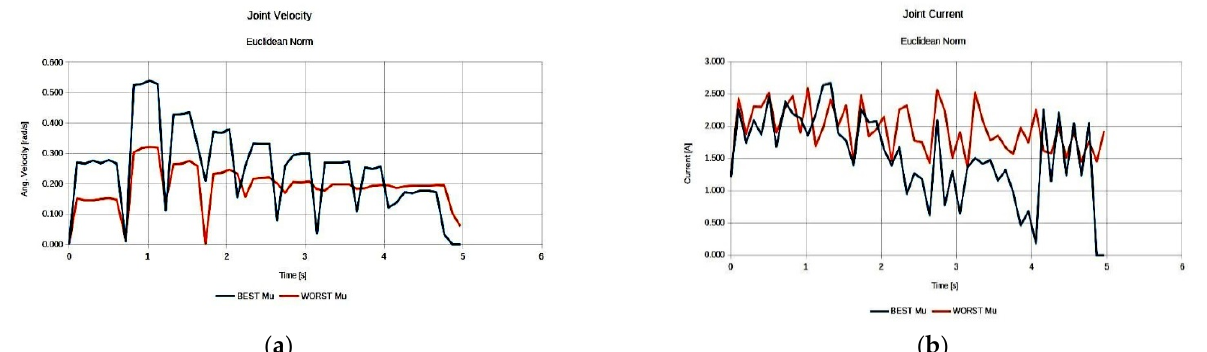
Figure 10. Comparison of the required joint velocities ( a ) and joint current usage ( b ) for the best anatomy and the worst performing anatomy under the effective mass performance index for task 1.